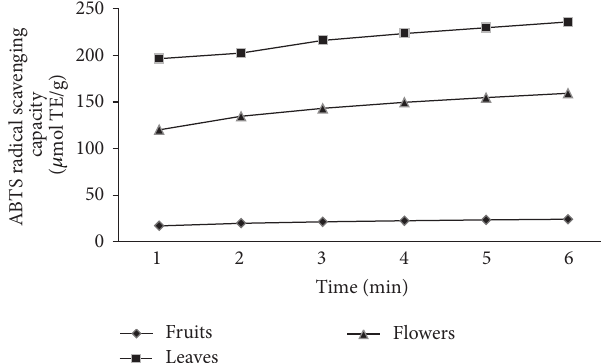
Figure 1: Changing of radical scavenging activity of ABTS assay with time.